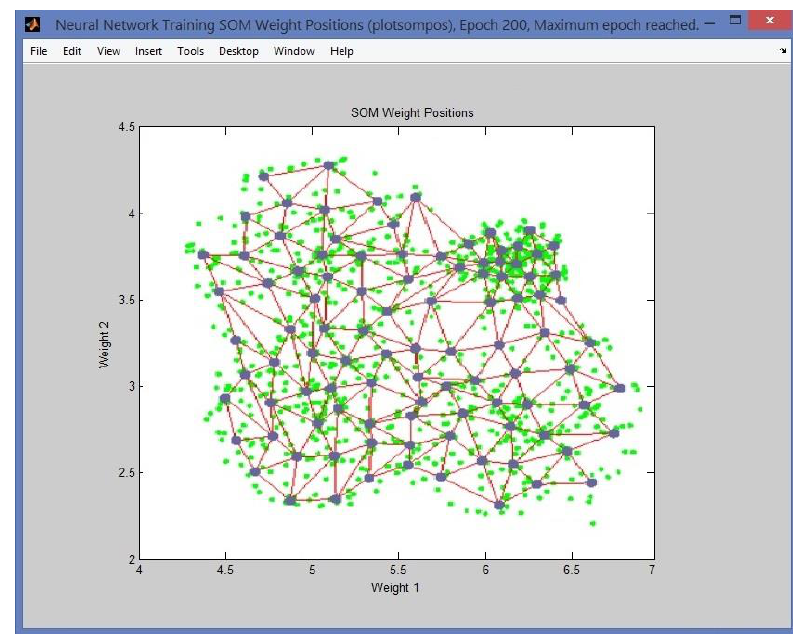
Figure 13. SOM weight positions plot using the GUI toolbox in MATLAB.